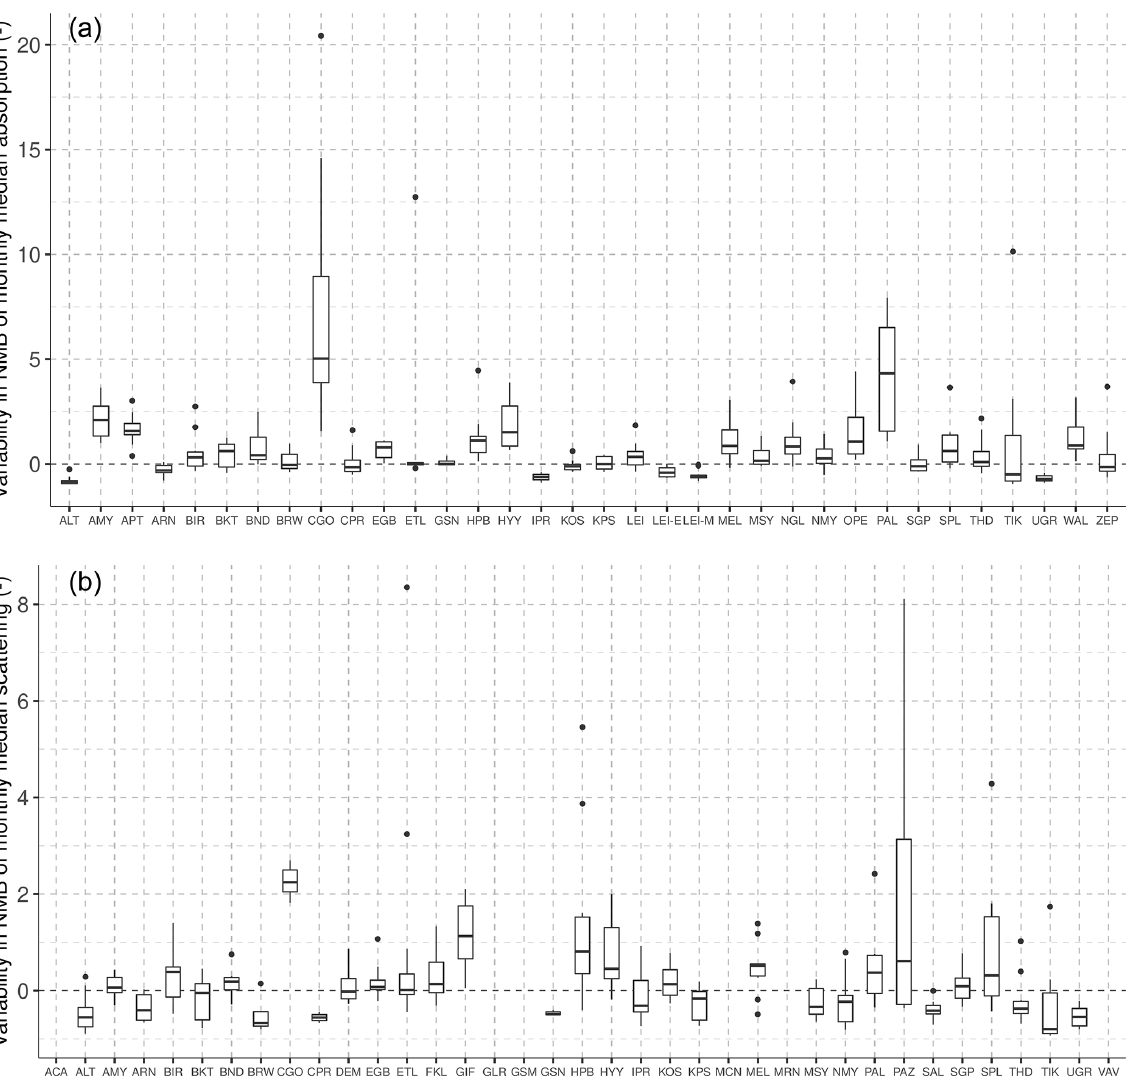
Figure 10. (a) Boxplots of the normalized mean bias (NMB) for each SARGAN site, based on monthly median in situ observation and the corresponding monthly median AeroCom simulation result. For scattering coefficient. (b) Boxplots of the NMB for each SARGAN site, based on monthly median in situ observation and the corresponding monthly median AeroCom simulation result. For absorption